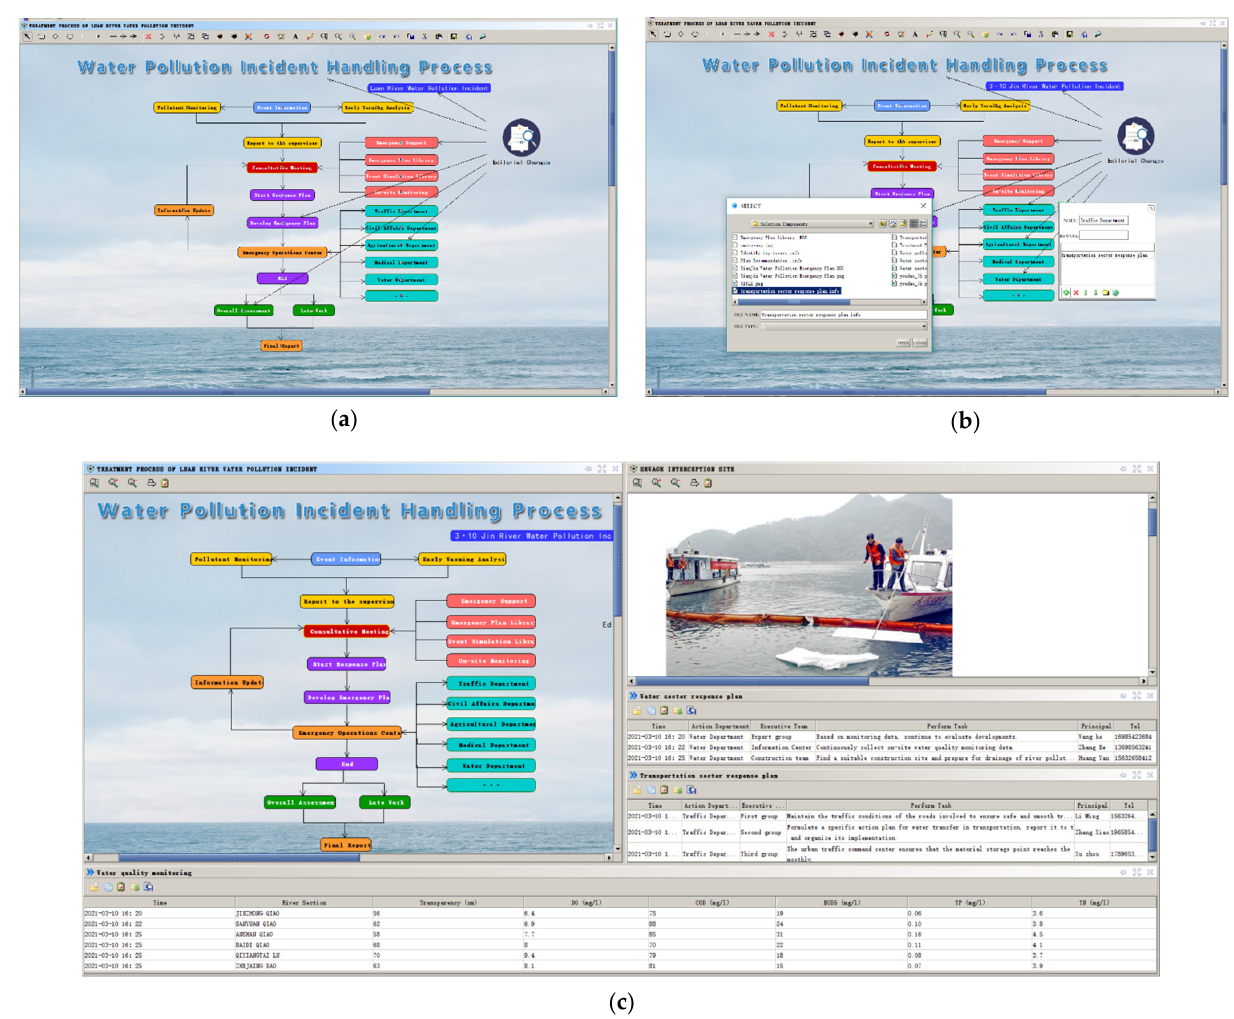
Figure 12. The result of the digital plan generation. ( a) Emergency process knowledge drawing. ( b ) Add components and modify. ( c ) Save and generate a new plan.